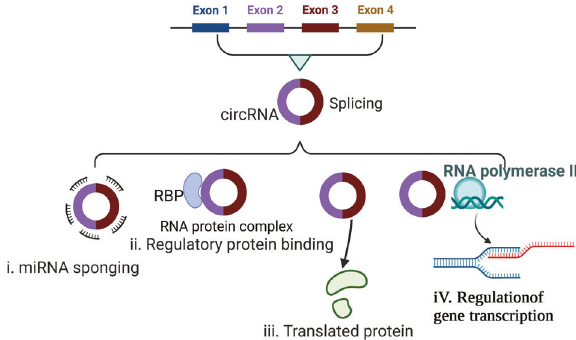
Fig. 1 Biological functions of circRNAs. (i) Serving as molecular sponges for miRNA. (ii) Regulating protein binding. (iii) Encoding protein. (iv) Regulating gene transcription. RBP RNA-binding